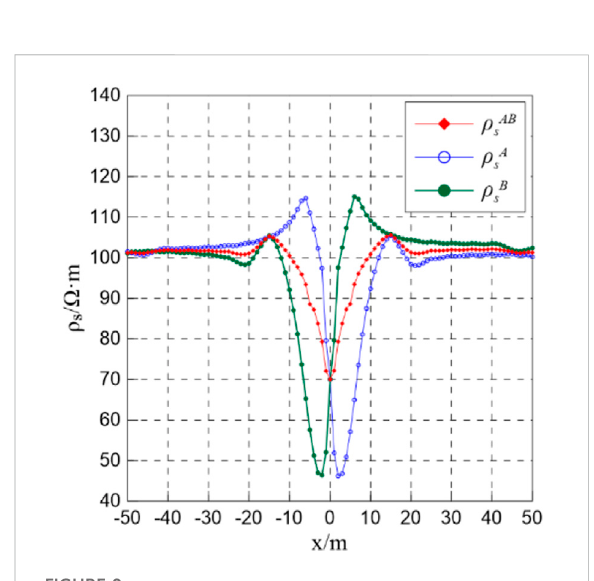
FIGURE 9 Linesourcejointpro fi